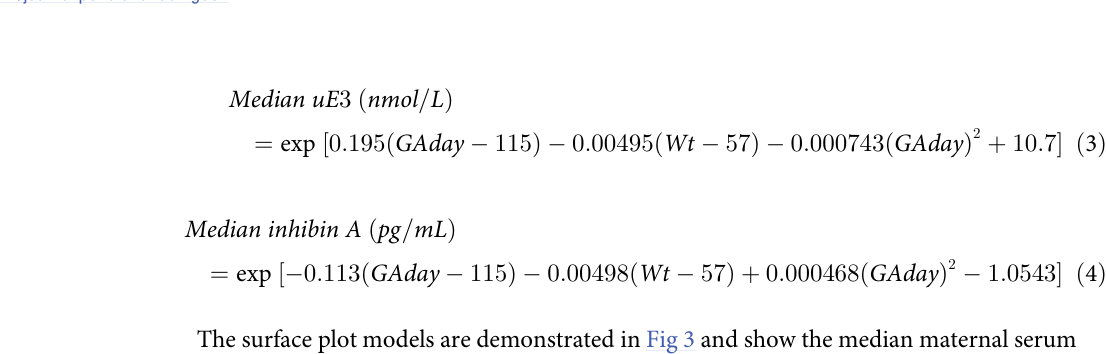
Median inhibin A ð pg = mL Þ ¼ exp ½(cid:0) 0 : 113 ð GAday (cid:0) 115 Þ (cid:0) 0 : 00498 ð Wt (cid:0) 57 Þ þ 0 : 000468 ð GAday Þ 2 (cid:0) 1 : 0543 � ð 4 Þ The surface plot models are demonstrated in Fig 3 and show the median maternal serum quadruple markers levels according to maternal weight and gestational age (days) of our popu- lation. Both serum AFP and uE3 levels increased with advanced gestation and were higher in patients with lighter maternal body weight. Serum free β -hCG levels decreased and then stabi- lized during the screening period with advancing gestational age and with smaller levels in